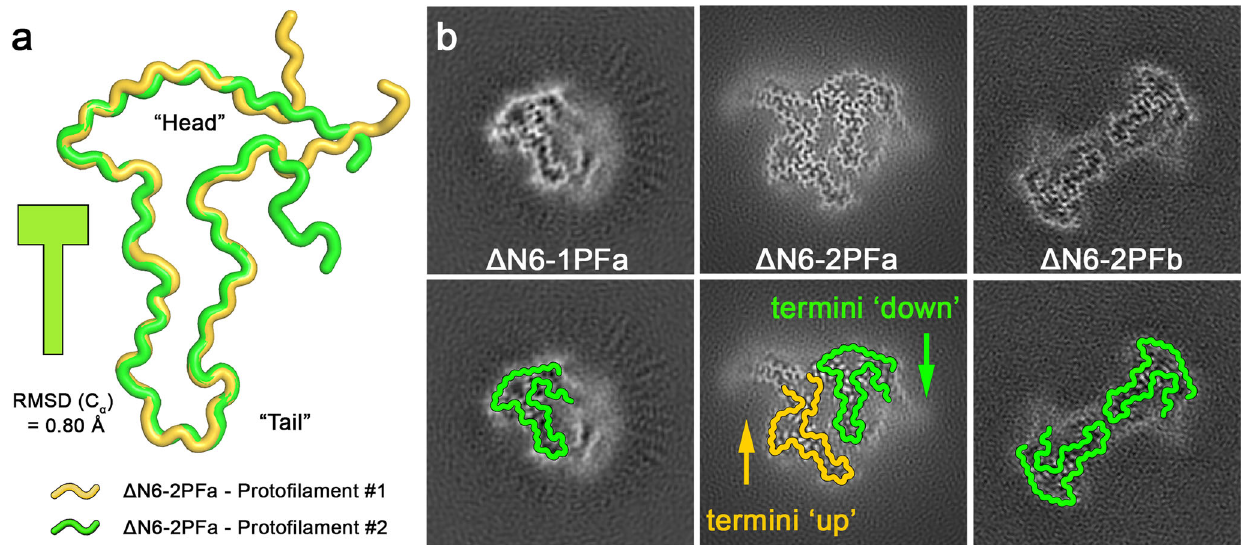
Fig.3|Ahammer-shapedmotifmakesupthecoreofall β 2 m- Δ N6polymorphs. a Thebackboneresiduesfortheatomicmodelof ΔΝ 6-2PFawasusedtocreatetube representationsofproto fi lament#1(yellow)andproto fi lament#2(green),de fi ning schematics thatcontain the hammer shapedmotif and indicating the directionthe